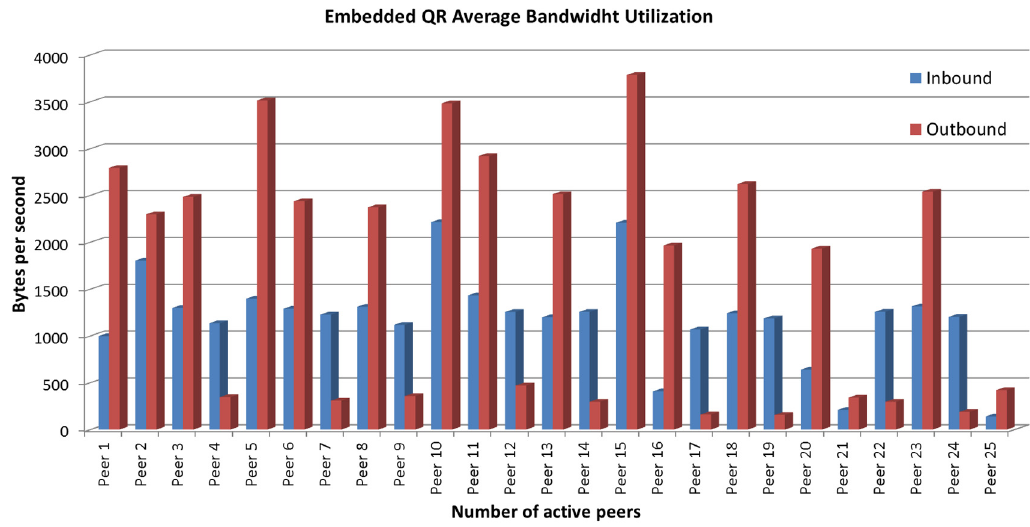
Figure 17. Average bandwidth utilization (inbound and outbound) per peer on a network of N = 25 peers.